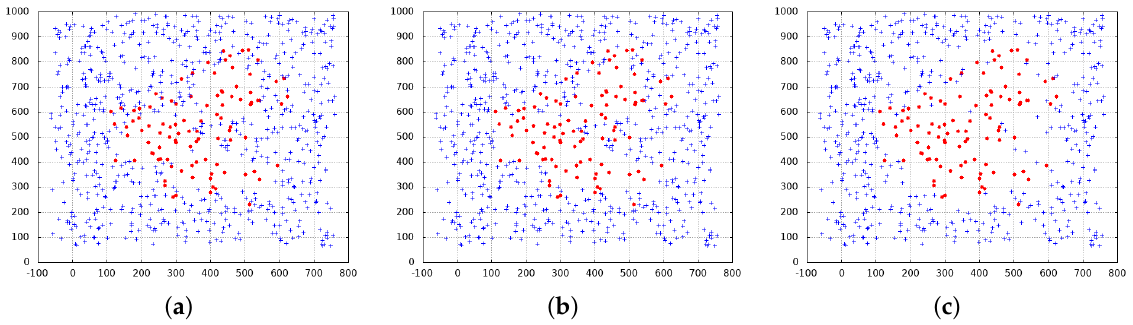
Figure 5. Scatter plots of the paw-50 database for the non-preprocessed set and the sets yielded by TL and